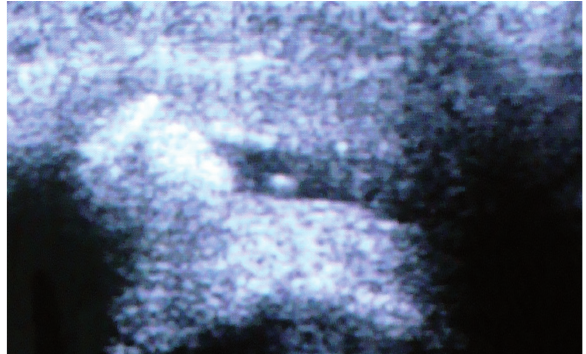
Figure 5 - Urethral calculus in